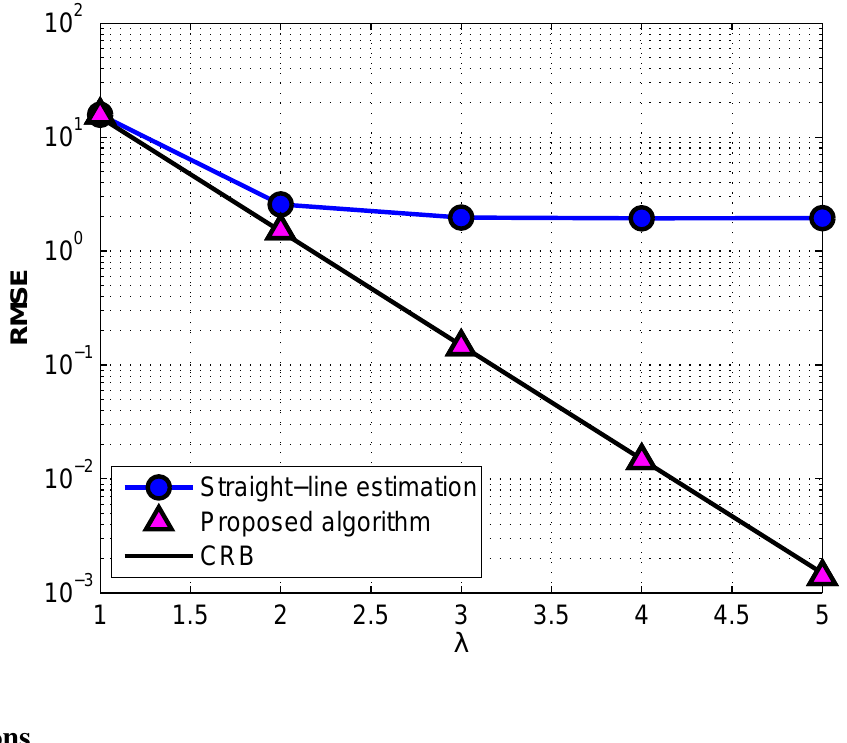
Figure 11. Performance of the proposed algorithm for difference values of noise